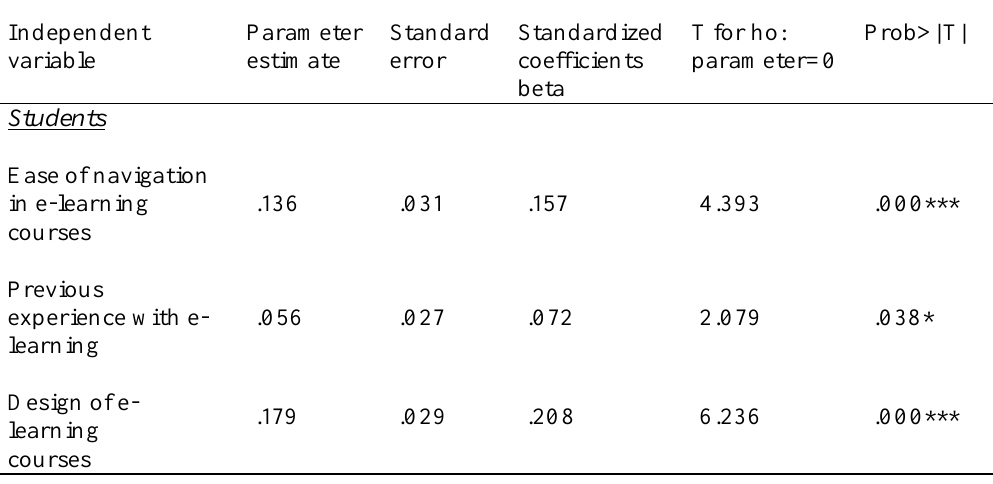
Regression Analysis – Dependent Variable: Development of E-Learning Skills